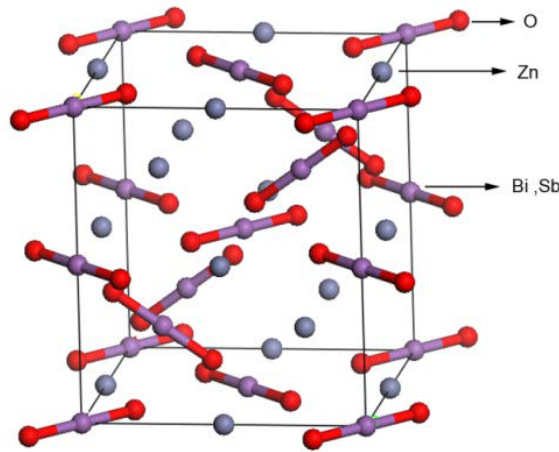
Figure 6. The structural model of ZnBiSbO corresponding to the XRD pattern shown in Figure